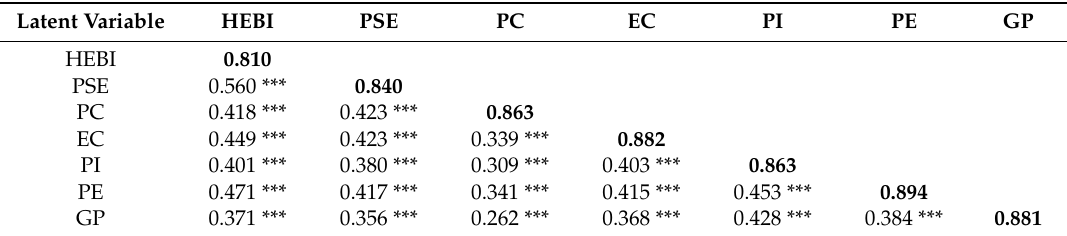
Table 3. Results of discriminant validity.